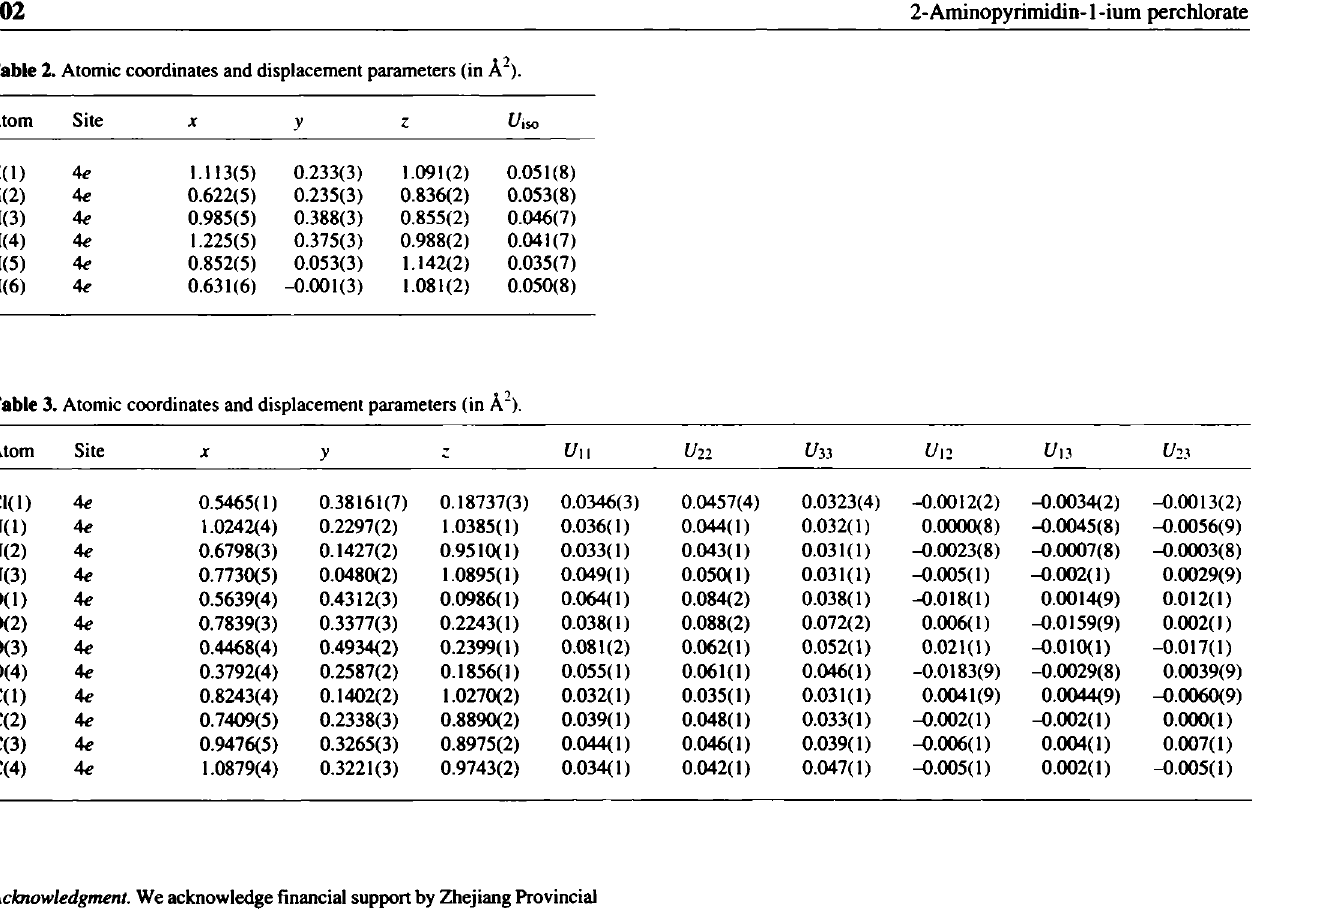
Table 2. Atomic coordinates and displacement parameters (in À 2 ).